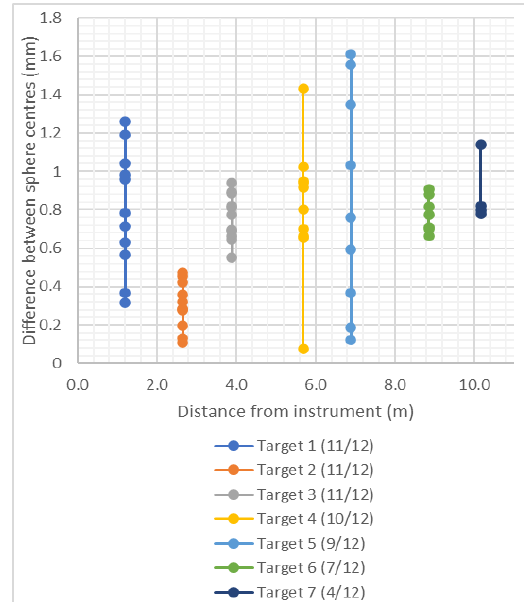
Figure 6: 3D difference between laser tracked sphere centre and laser scanned sphere centre vs. distance from instrument.